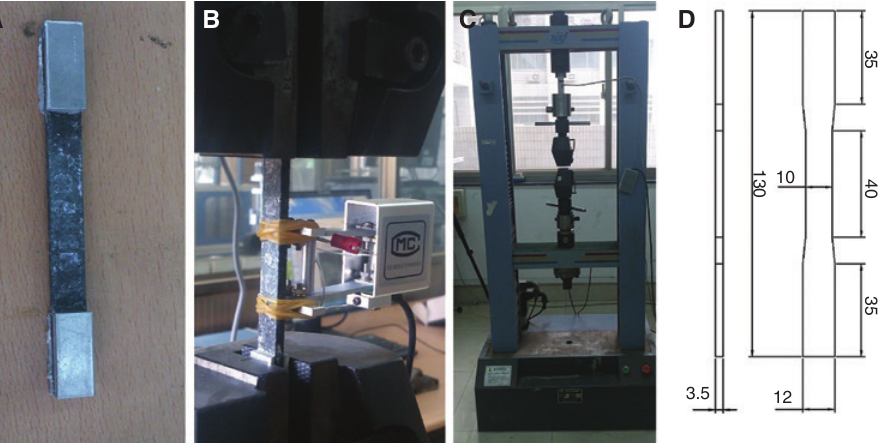
Figure 4: Specimens and system for the tensile test: (A) specimen, (B) specimen with strain extensometer, (C) WDW-100 electromechanical testing system, and (D) the size of specimen (unit: mm).